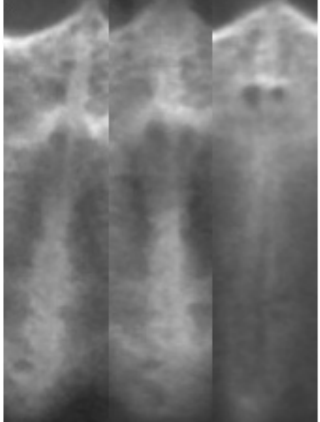
Figure 7. The fused image examples after direct image fusion process.